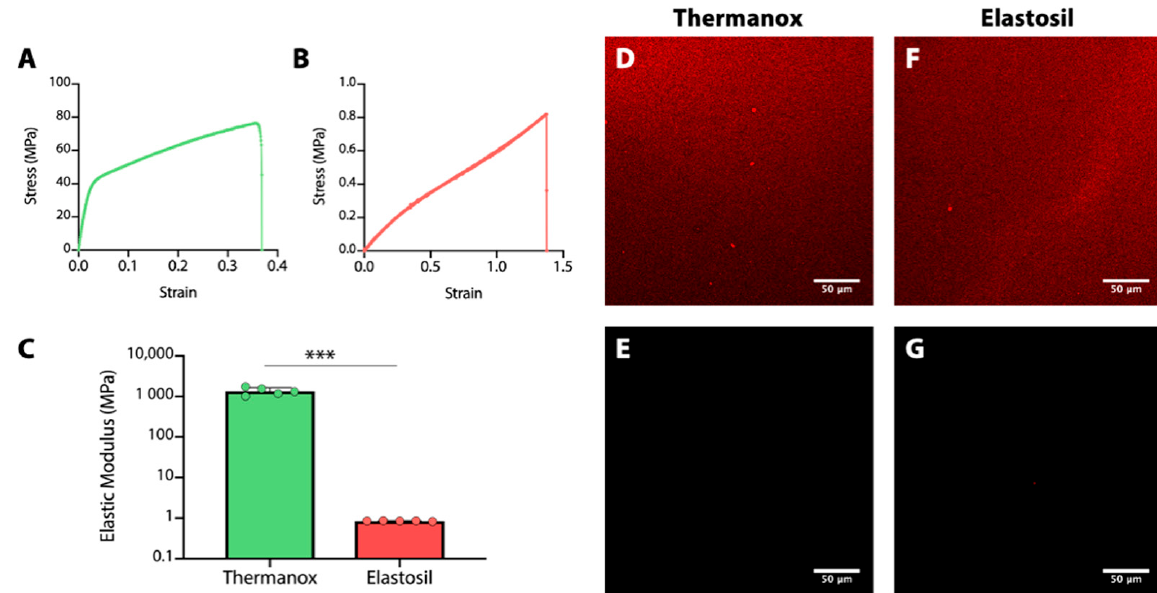
Figure 1. ( A , B ) Stress-strain curves obtained through a tensile testing for Thermanox™ Coverslips and Elastosil ® Film, respectively, and ( C ) the corresponding elastic modulus values calculated as the slope of the linear elastic region (*** p < 0.001, n = 5). ( D – G ) Immunostaining of fibronectin: Thermanox™ Coverslips with FN coating and without, D and E respectively; Elastosil ® Films with FN coating and without, F and G respectively ( n = 2 for each condition).